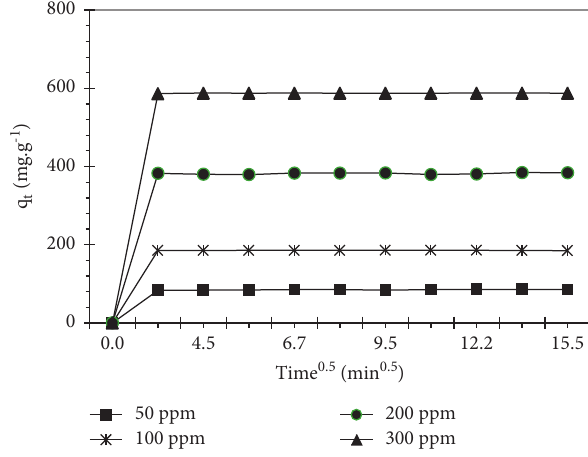
Figure 6: Intraparticle diffusion analysis.